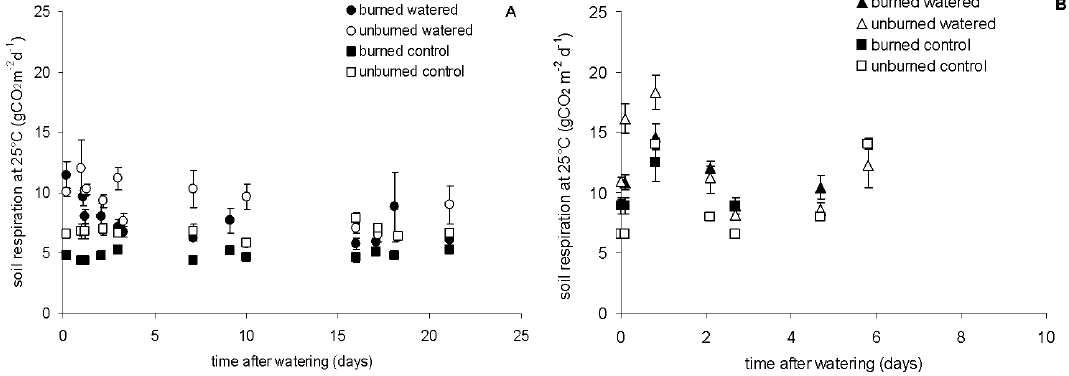
Fig. 2. Soil respiration normalized at 25 ◦ C, using a Q 10 of 2.78 (gCO 2 m − 2 d − 1 ) in function of time after watering during the 1st campaign (A) one month after burning and the 2nd campaign (B) eight months after burning. The vertical bars correspond to one standard error ( n = 3 to